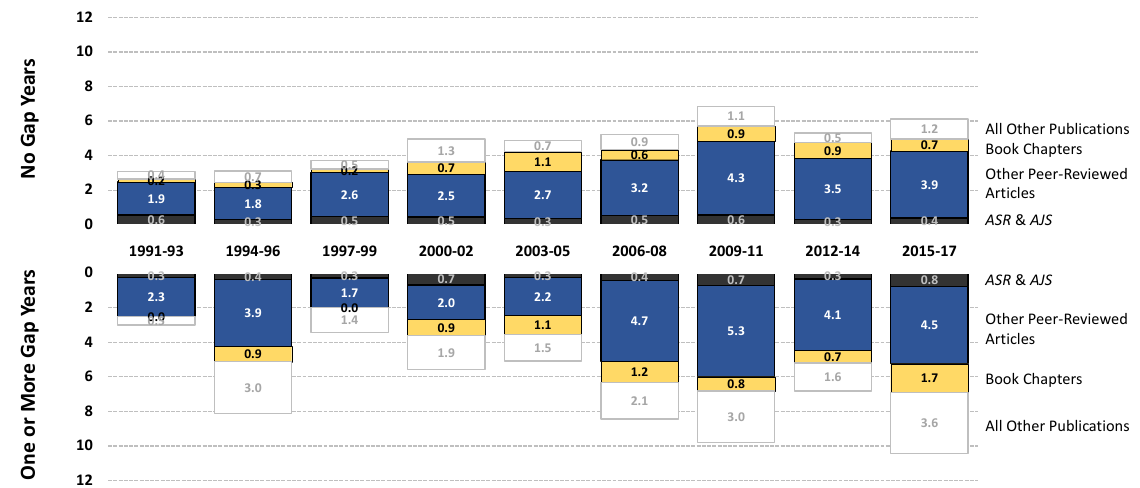
Figure 7: Mean number of publications for new assistant professors by type, year, and whether the new assistant professor had gap